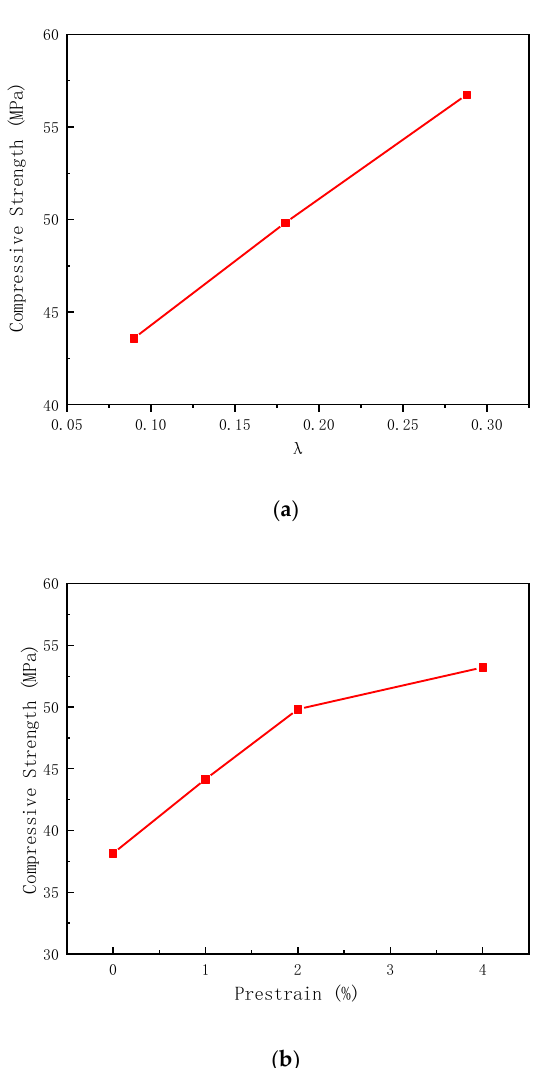
Figure 12. Ultimate compressive strength of SMA reinforced columns with different reinforcement amount and different prestraining levels: ( a ) Ultimate compressive strength of test specimens C-SS8-P2, C-SS4P-2, and C-SS2.5-P2 with different reinforcement amount; ( b ) Ultimate compressive